Question: Write a caption explaining this figure to a reader.
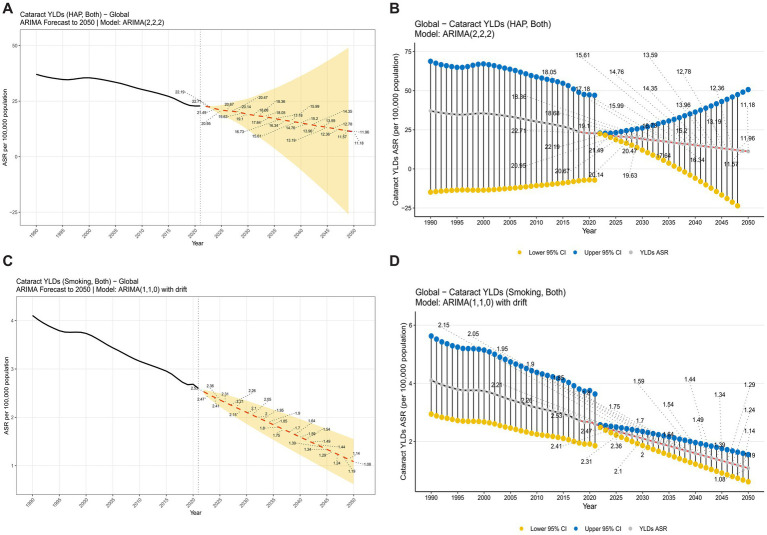
Answer: ARIMA models were applied to project trends in cataract ASYR attributable to HAP (A, B) and smoking (C, D) from 1990 to 2050. Panels A and C show overall temporal trends, while Panels B and D present detailed uncertainty information. ASYR, age-standardised YLD rate; HAP, household air pollution; ARIMA, autoregressive integrated moving average.